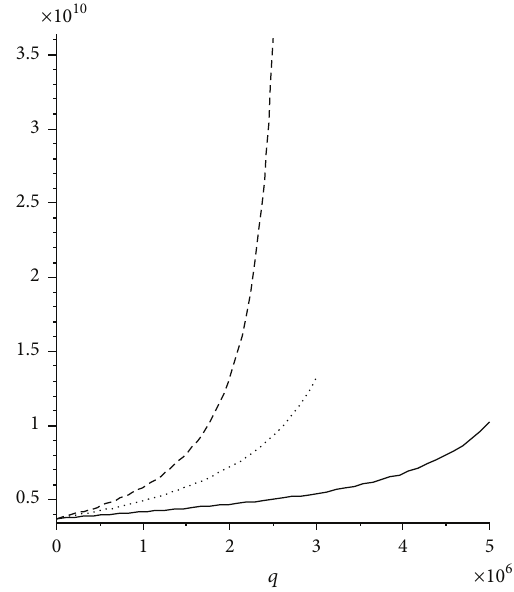
Figure 2: Plot of the jet-quenching parameter in terms of the black hole charge. We fixed our parameters as 𝛼 󸀠 = 0.5 , 𝜆 = 6𝜋 , and 𝑇 = 300 MeV. The solid line represents the case of 𝑞 The dotted line represents the case of 𝑞 1 = 𝑞 2 = 𝑞, 𝑞 3 = 0 . The dashed line represents the case of 𝑞 1 = 𝑞 2 = 𝑞 3 = 𝑞 . It shows that increasing the number of black hole charges increases the value of the jet-quenching